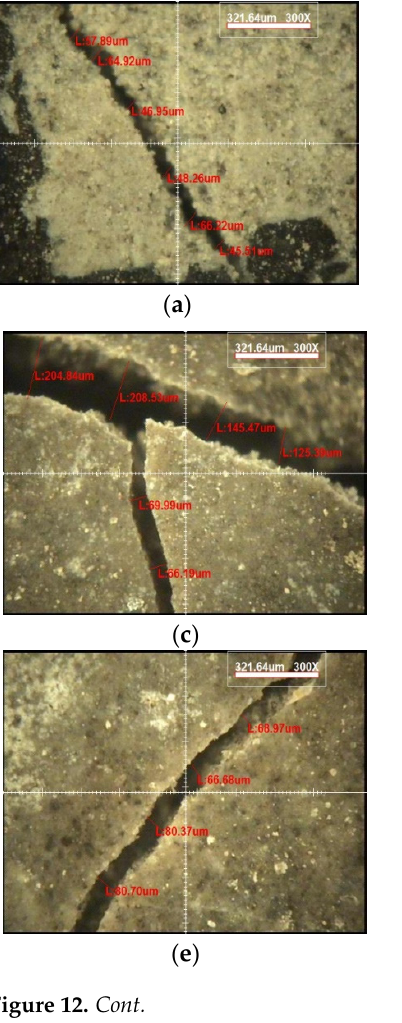
( h ) Figure 12. Results of observation of crack: ( a ) plain (initial crack) ( b ) plain (crack healing), ( c ) SHC 10%—850 μ m (initial crack) ( d ) SHC 10%—850 μ m (crack healing), ( e ) SHC 10%—600 μ m (initial crack) ( f ) SHC 10%—600 μ m, (crack healing), ( g ) SHC 10%—300 μ m (initial crack), ( h ) SHC 10%— 300 μ m (crack healing). 4. Conclusions The results of the healing performance evaluation of solid capsules for the self-heal- ing of crack in cementitious composites were as follows: (1) The mechanical-healing performance of cement composites according to the different mixing proportions of solid capsules showed that the compressive strength healing efficiency was high when the capsule proportion was 10% and its size was in the range of 300 μ m to 850 μ m. In case of splitting tensile strength, the healing perfor- mance was high when the capsule proportion was 15% and its size was 850 μ m. (2) The decrease rate of the permeability of cement composites according to different proportions of solid capsules was more than 95% when the capsule size was 850 μ m. It was also found that healing effects can be expected even at 600 and 300 μ m. (3) It was confirmed that the cracks were healed by the reaction products of the self- healing solid capsules. When using capsule sizes of 850 μ m to 600 μ m, the crack width tended to heal up to approximately 200 μ m. These results suggest that the optimal capsule healing efficiency can be obtained by selecting an appropriate capsule proportion and size in consideration of the characteristics of the object to which the capsule has to be applied. The solid capsule used in this study needs moisture for the healing reaction. Therefore, the use of solid capsules is suitable for